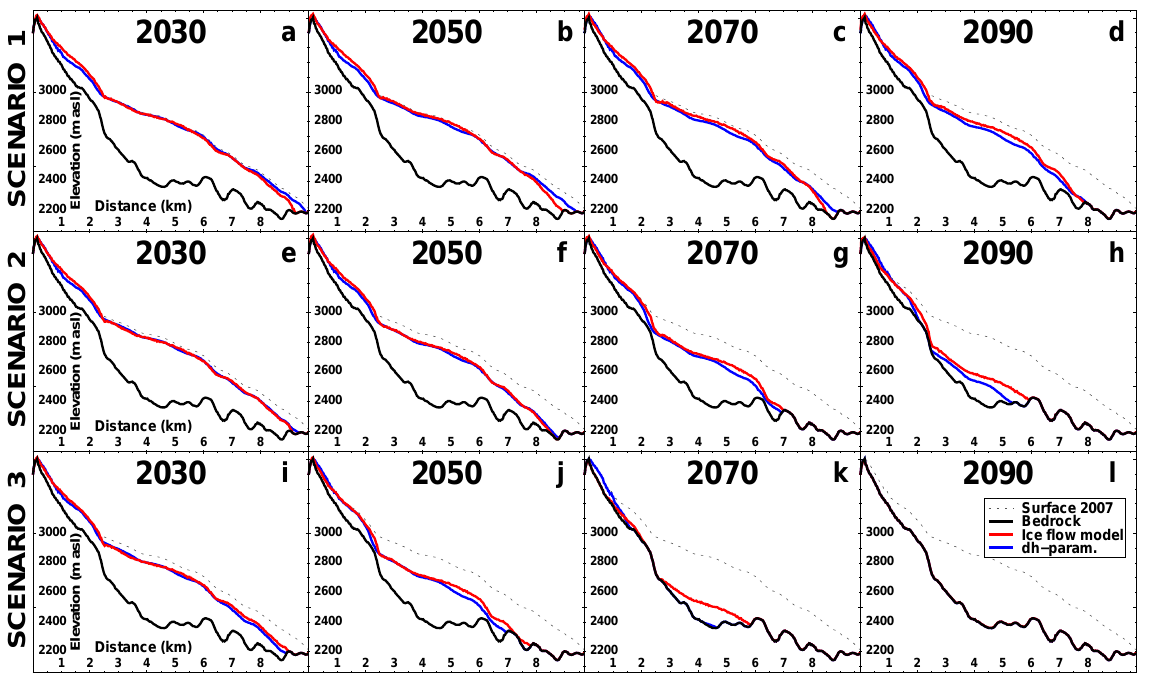
Fig. 8. Evolution of glacier surface elevation along a longitudinal profile calculated for Rhonegletscher using the 3-D ice flow model and the ∆ h -parameterization. Results for different climate change scenarios are shown.